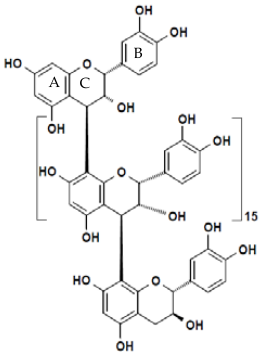
Figure 1. Microbiota heterocyclic C ring cleavage of flavonoids; (|||) positions of the potential C-ring cleavages [42].